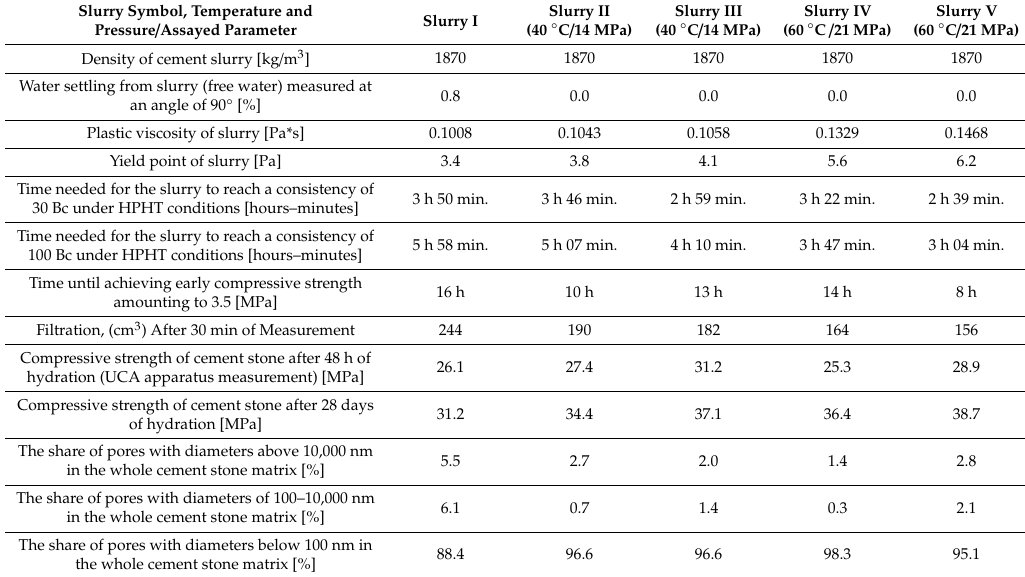
Table 5. Parameters of slurries and cement stones with an addition of n-SiO 2 tested under HPHT